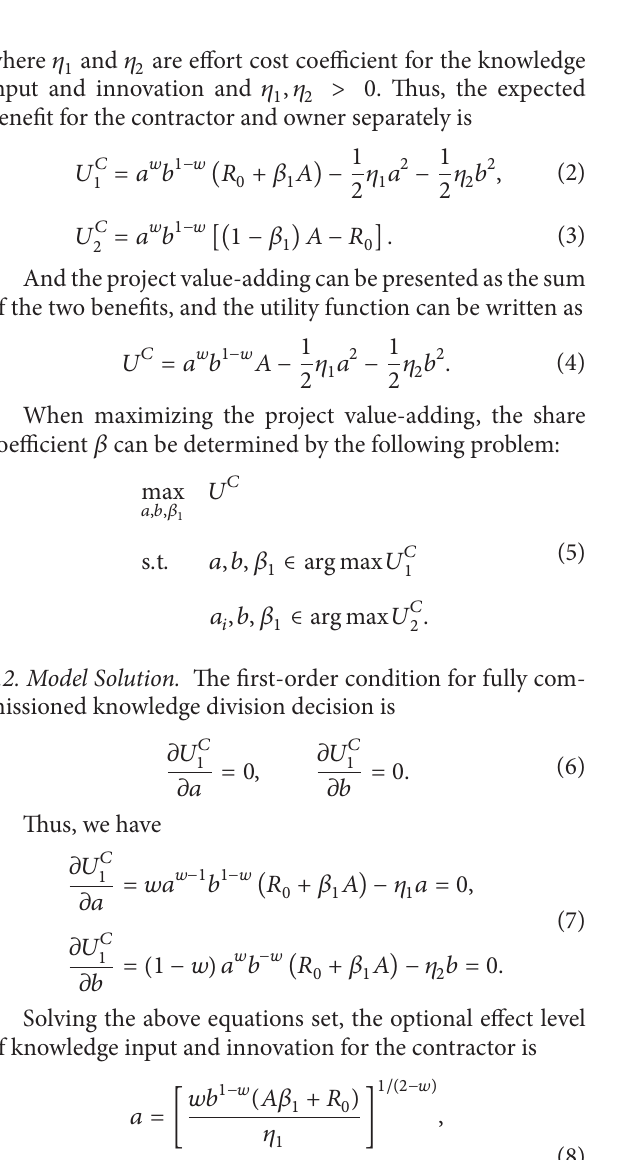
Figure 1: Knowledge flow in collaborative innovation of supply chain